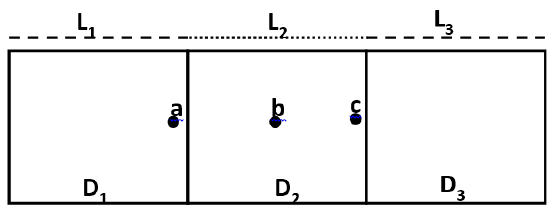
Figure 6. Scheme for the inversion of a long radar image, making use of a sequence of adjacent investigation domains and a relative sequence of observation lines.